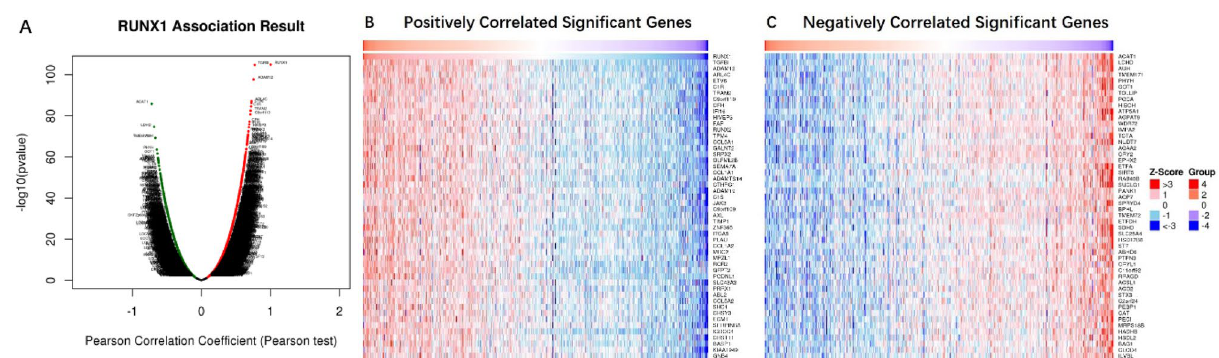
Figure 5. Genes differentially expressed in correlation with RUNX1 in KIRC by LinkedOmics. ( A ) Volcano plots in analyzing differential expression genes correlated with RUNX1 in KIRC. ( B , C ) Heat maps showing genes positively and negatively correlated with RUNX1 in KIRC (TOP 50). Red indicates positively correlated genes and blue indicates negatively correlated